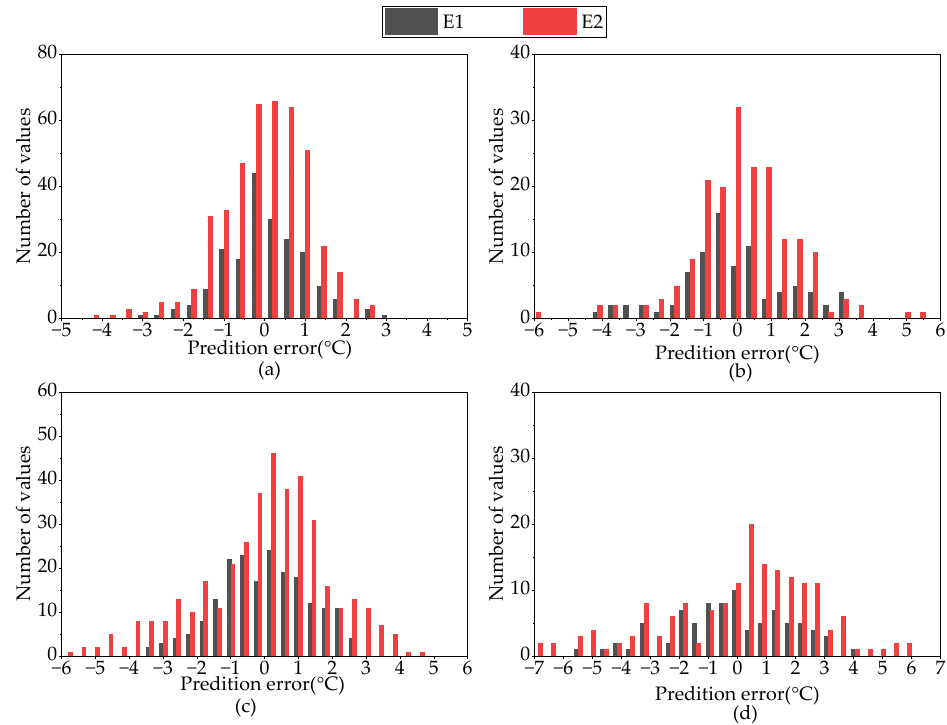
Figure 11. Histogram of ( a ) model development and ( b ) validation of the prediction error for 𝑇 𝑤𝑒𝑡 and of ( c ) model development and ( d ) validation of the prediction error for 𝑇 𝑑𝑟𝑦 .